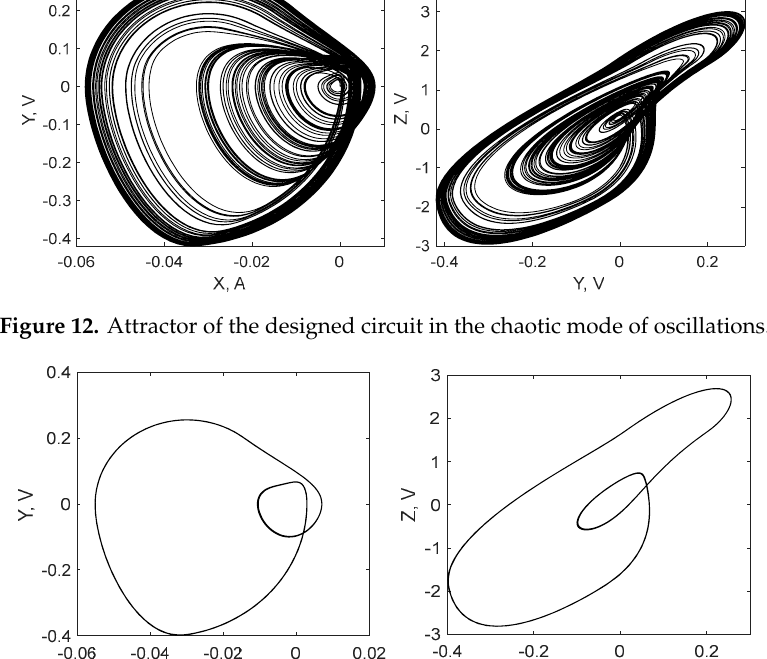
Figure 13. Attractor of the designed circuit in the periodic mode of oscillations.